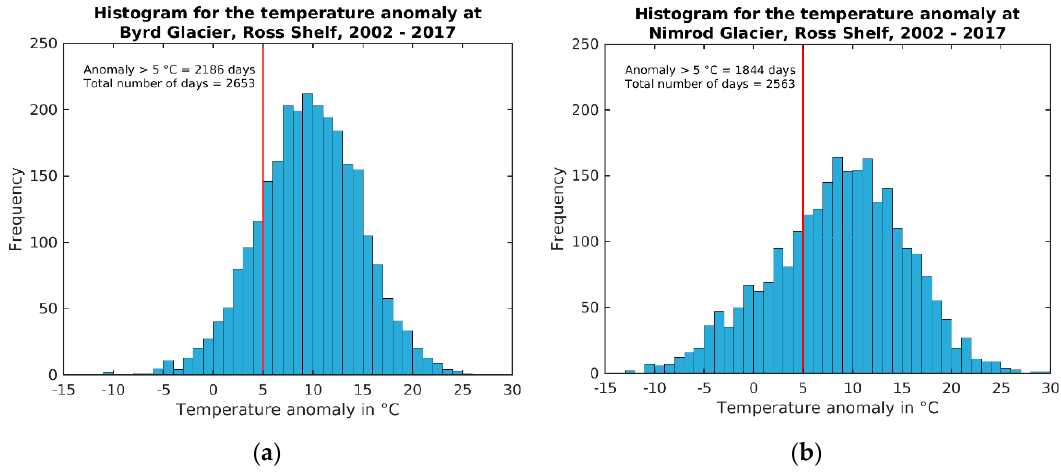
Figure 7. Surface temperature anomaly distribution (1K bins) for winter (April–September) 2002 to 2017 for the exit regions of a) Byrd Glacier and b) Nimrod Glacier (marked by crosses in Figure 6). The red line marks a value of +5°C.